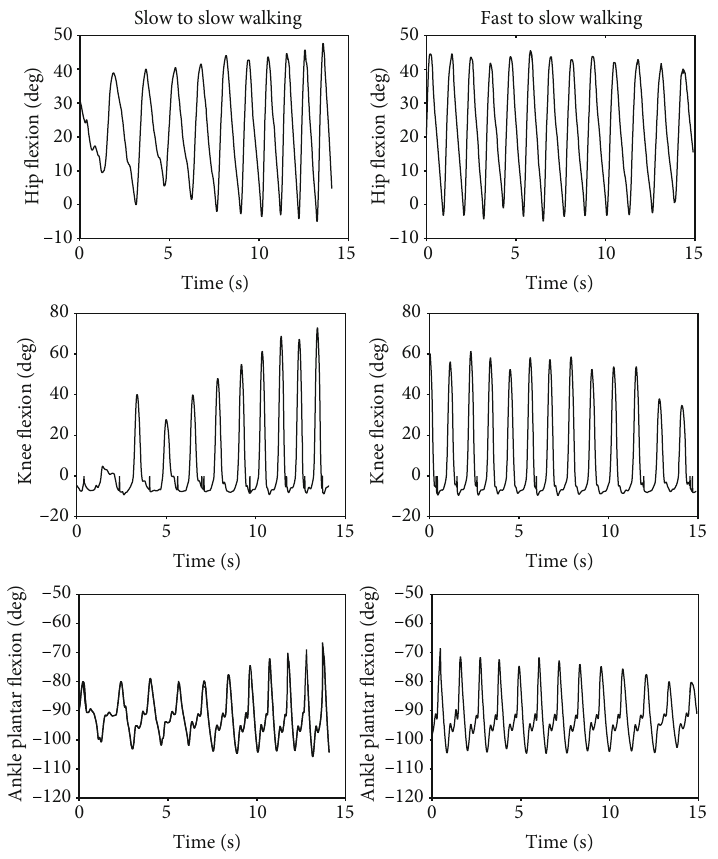
Figure 15: Joint angles of transfemoral prosthesis user PR02 during the transition from slow (0.6 m/s) to fast (1.1m/s) walking (left fi gures), and vice versa (right fi gures). The left fi gures are taken from trial 21 and the right fi gures are taken from trial 23.